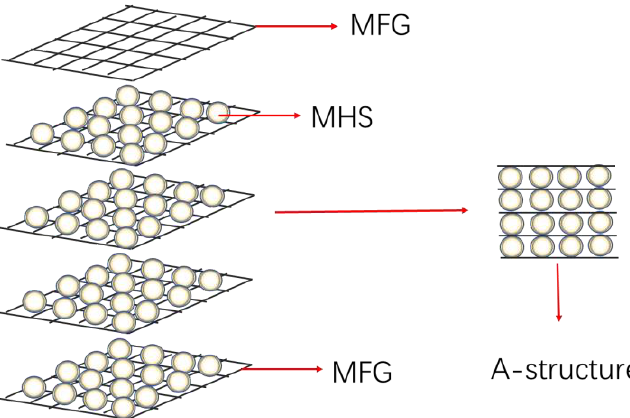
Figure 4. The fabrication schematic of MHSs layered structure.